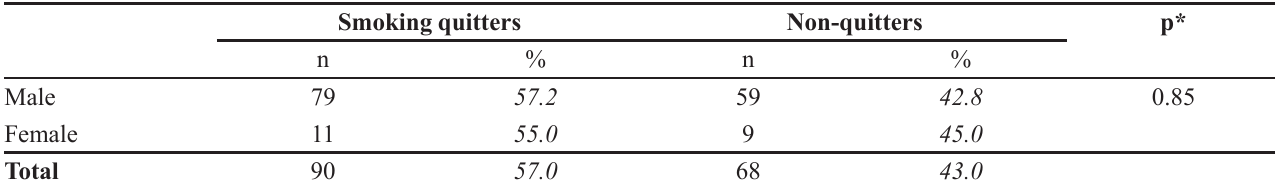
TABLE III - The success of smoking cessation according to